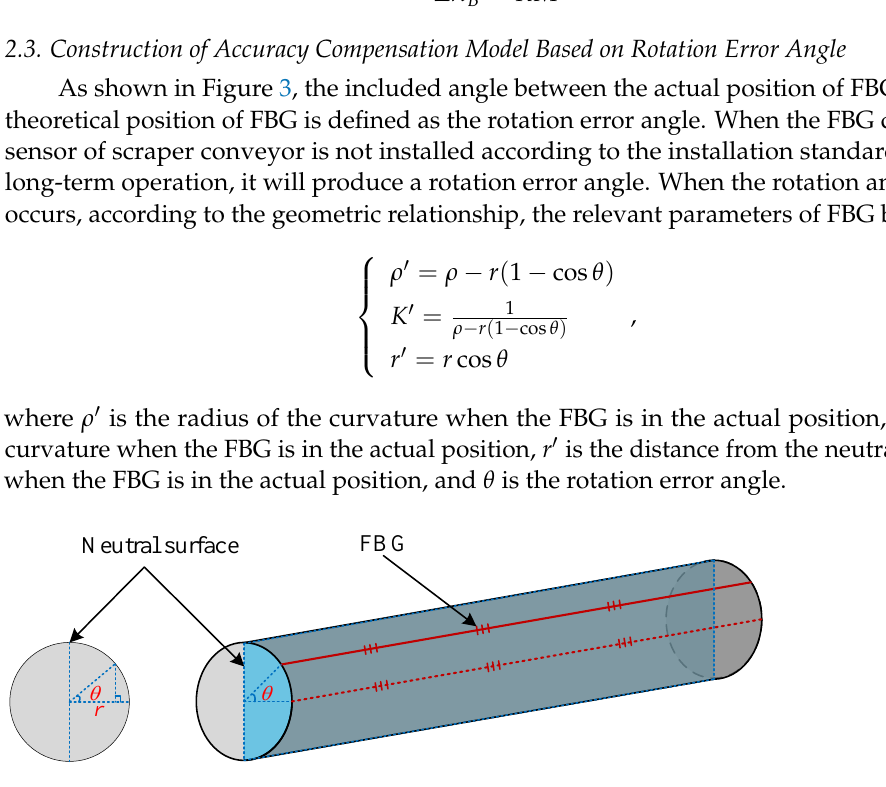
Figure 3. Schematic diagram of the FBG curvature sensor generating a rotation error angle.